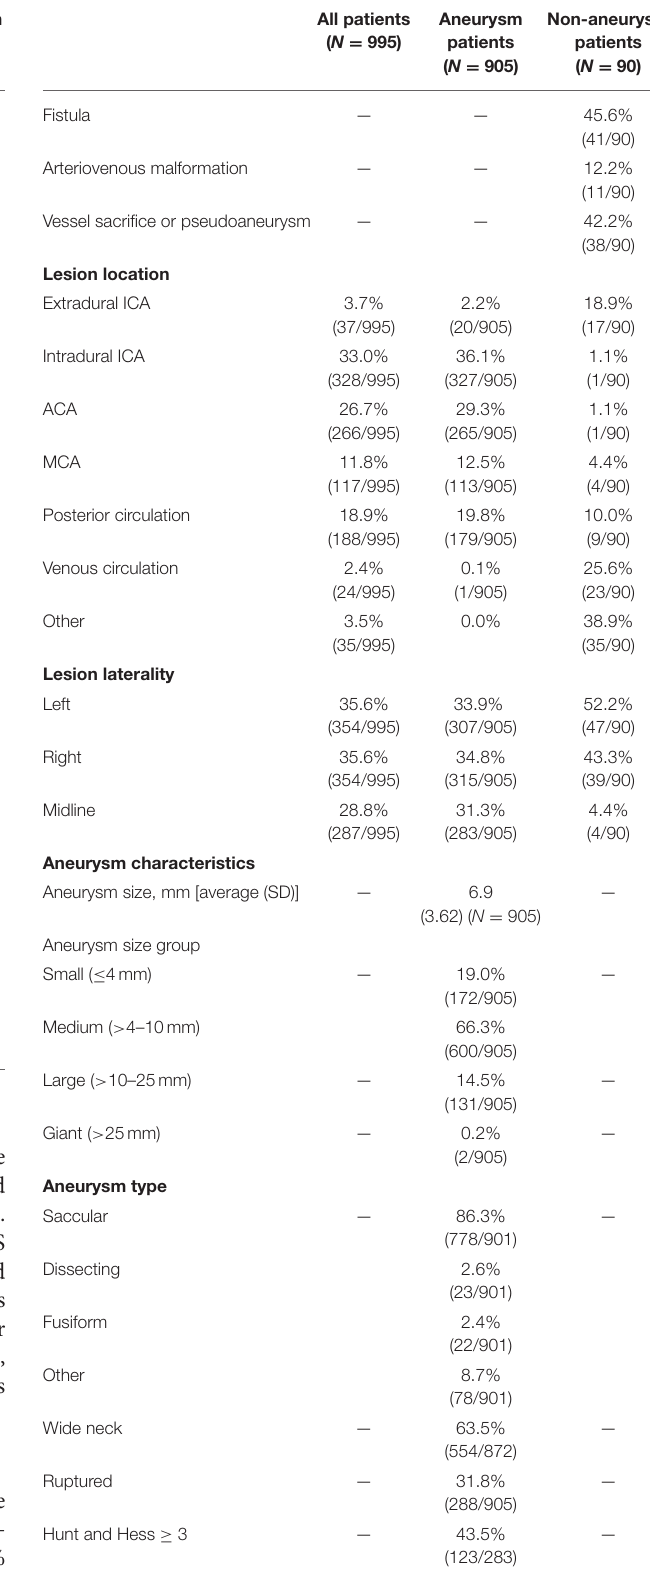
TABLE 1 | Demographics and baseline